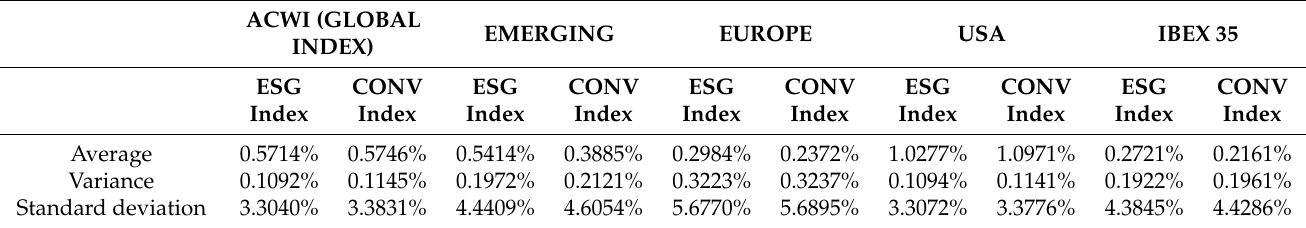
Table 6. Data Analysis.